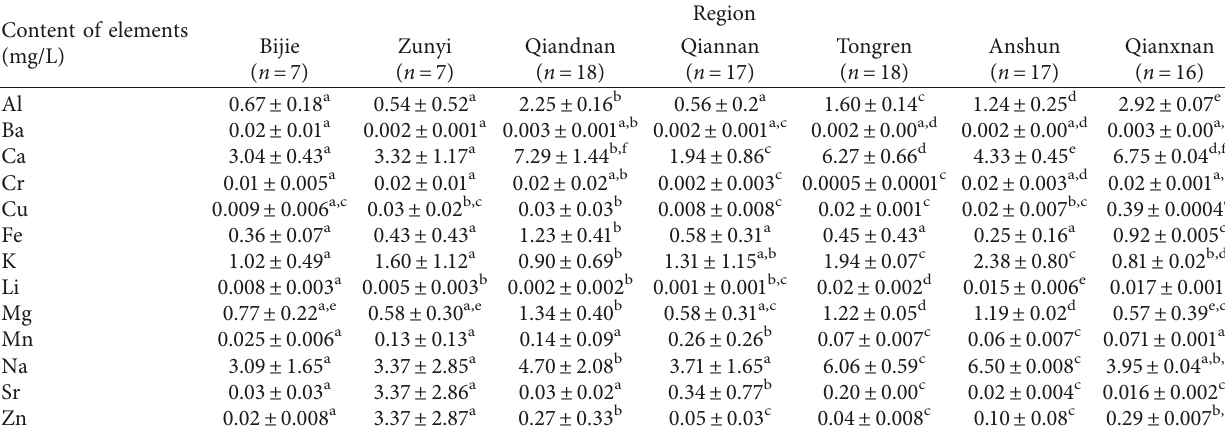
Propanoic acid Butyric acid a,b,c,d Means in the same row with different superscript letters are statistically significantly different according to one-way ANOVA ( p < 0 . 05); these values indicate those organic acids that are responsible for sauce-flavor baijiu from different regions. Table 3: The mean ± standard error value content of thirteen elements of sauce-flavor baijiu from seven different origins (unit: mg/L). Content of elements